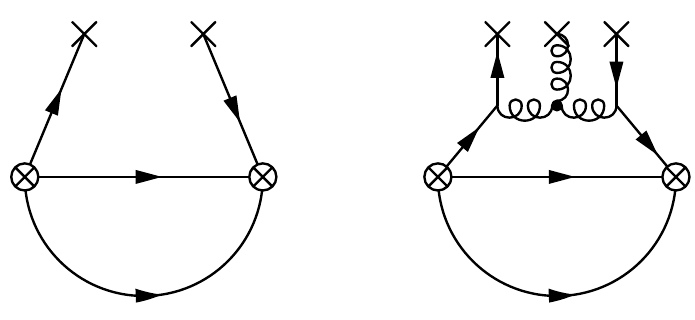
Figure 3 . One-loop and two-loop contributions to the OPE correlation function (4.25). Insertions of the interpolating currents ⌘ ( x ) or ¯ ⌘ (0) are denoted by circled crosses. The lower quark lines correspond to the free propagator S (0) ( x ) of a massless quark, while the crosses indicate interactions with either quark or gluon background fields. In the right graph the dotted vertex represents the insertion of the Weinberg-type operator O 6 .